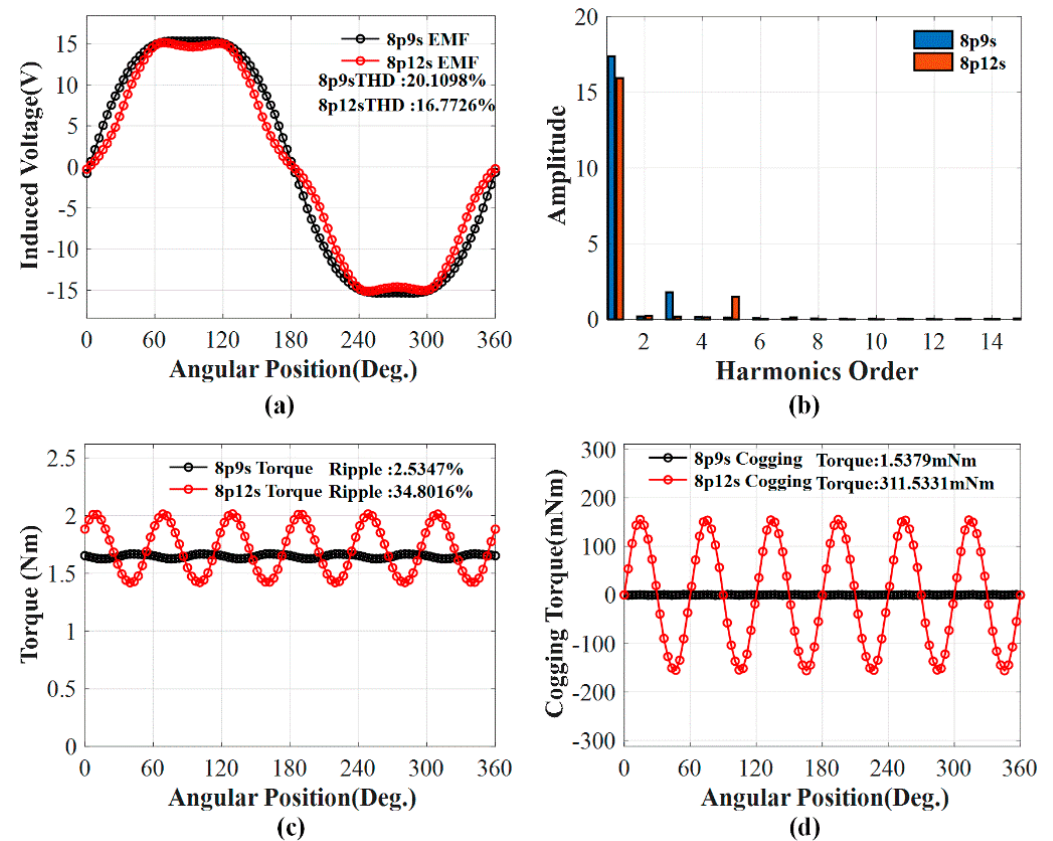
Figure 2. Comparison of the analysis results of permanent magnet machines with two different pole/slot combinations: ( a ) back-EMF, ( b ) THD of back-EMF, ( c ) torque ripple, and ( d ) cogging torque.